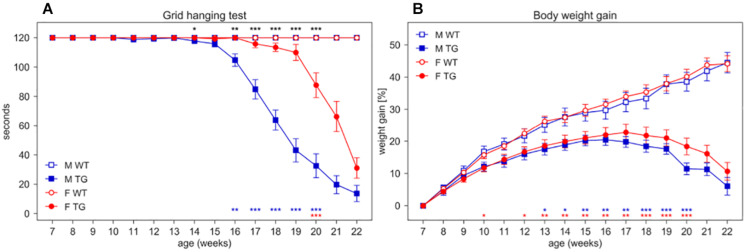
Grid hanging test and body weight gain. (A) Latency to fall per mouse (average time ± SEM) of mice hanging from an inverted grid. (B) Average percentage of body weight gain ± SEM (per mouse) calculated from initial weight at age 7 weeks. Measures were taken weekly (weeks 7–22) in male (M, blue squares) and female (F, red circles) WT (open symbols) and SOD1G93A (TG, filled symbols) mice. N of mice per group: M WT = 17; M TG = 18; F WT = 22; F TG = 20. In each sex group (males = blue stars, females = red stars) *p < 0.05, **p < 0.01, ***p < 0.001 WT vs. TG, D/AP post-hoc procedure. Since we found a significant Genotype X Sex X Age interaction in the grid hanging test (nparLD test, Genotype X Sex X Age interaction: Statistic = 11.630, df = 5.206, p < 0.001) we compared TG males with TG females with D/AP post-hoc tests in A (*p < 0.05, **p < 0.01, ***p < 0.001, black stars).